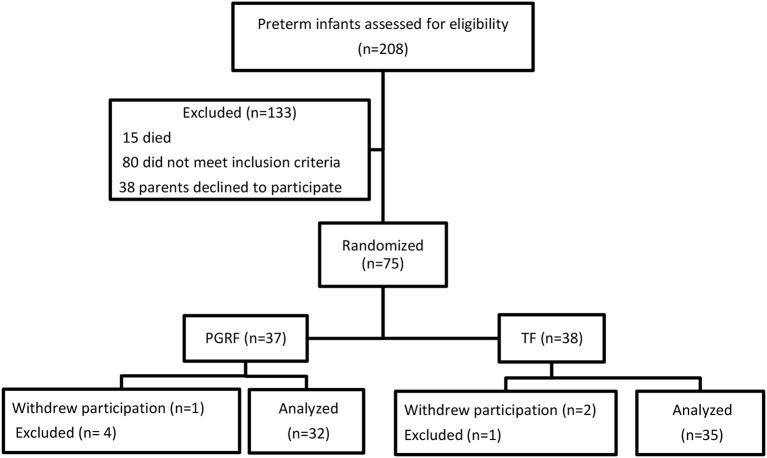
Flowchart of the study participants.